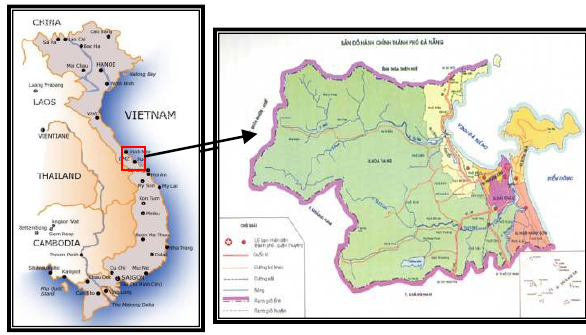
Figure 1. General location of Danang city, Vietnam